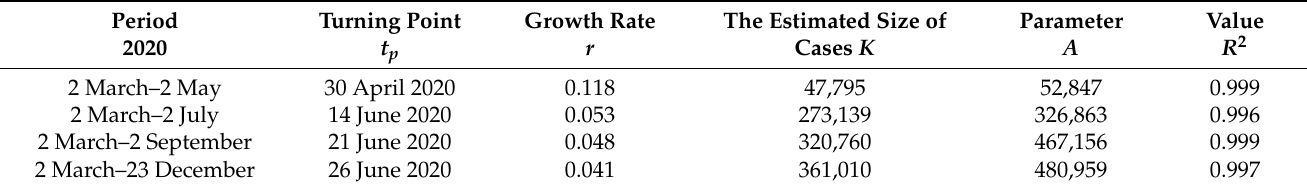
Table 3. The estimation results of parameters in the logistic growth model for various periods from daily cases data of COVID-19 infected in Saudi Arabia based on data compiled by WHO